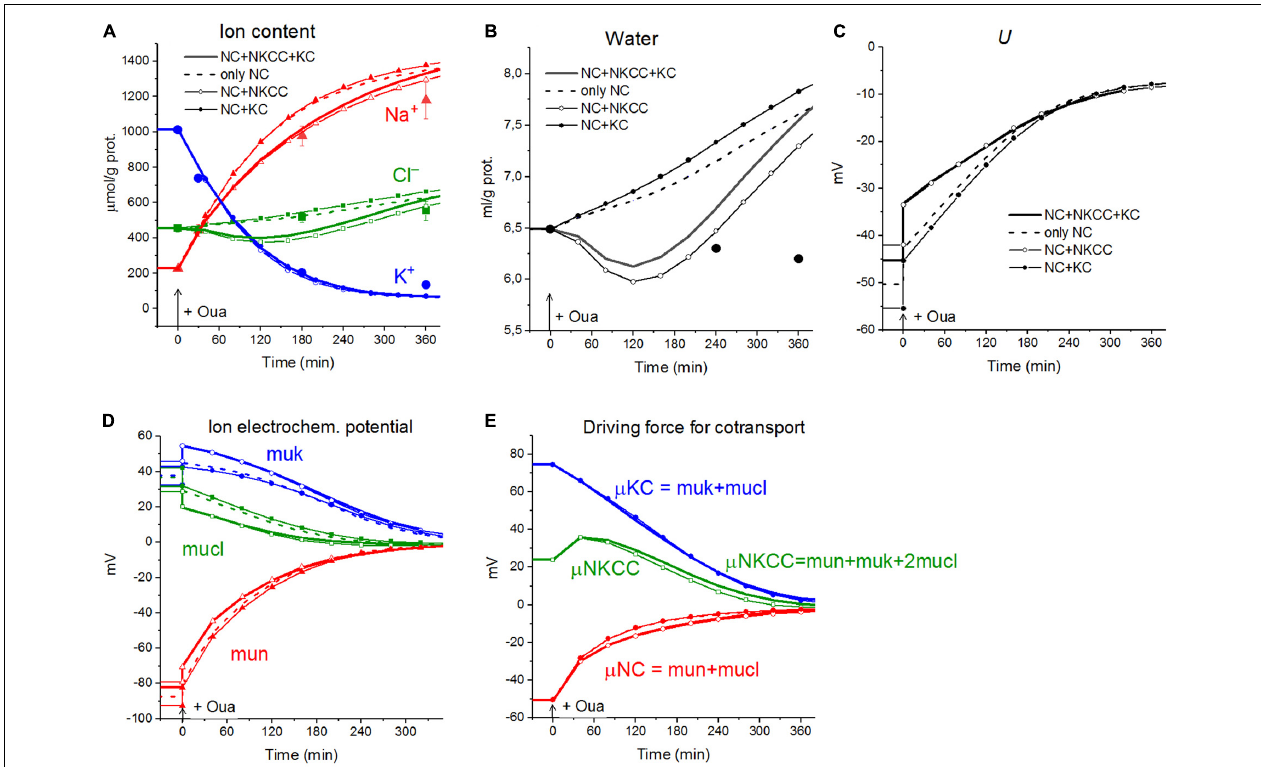
FIGURE 1 | Disturbance of cell ionic homeostasis after stopping the pump in the real U937 cells (large symbols) and in U937 cell model with different set of cotransporters at the unchanged over time parameters as in U937 cells, equilibrated with the standard RPMI medium (lines with or without small symbols). Large symbols show means ± SE for n = 4, small SE values are masked by symbols. The pump was blocked by ouabain at t = 0, corresponding to a change in beta from 0.039 to 0. The other parameters were unchanged and are shown in Table 2 , cells A . Water in ml/g protein was obtained by multiplying the calculated V/A by the content of impermeant osmolytes A in mol/g